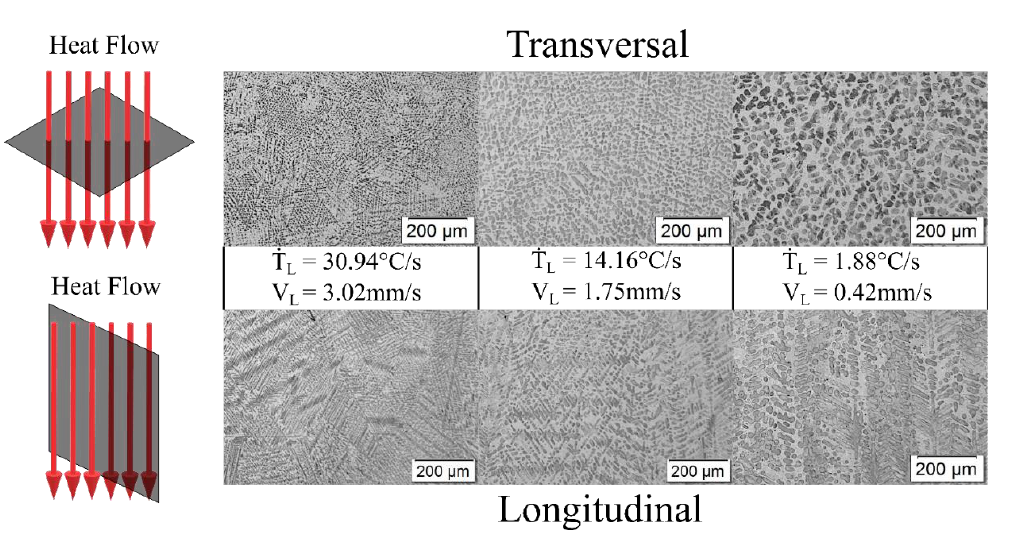
Figure 14. Typical microstructures along the length of the DS Zn-11wt.% Al alloy casting. [ Ṫ L = cool- ing rate of liquidus isotherm, and V L = growth rate of liquidus isotherm].